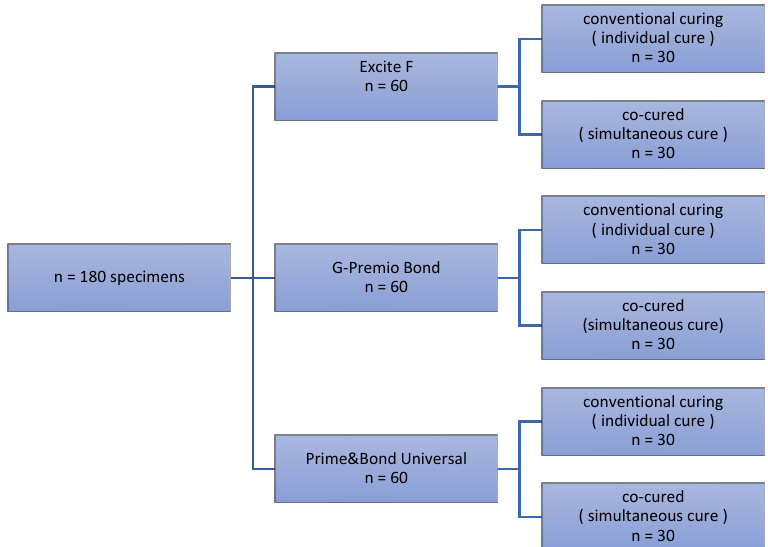
Figure 1. Flowchart of the groups used in the study.